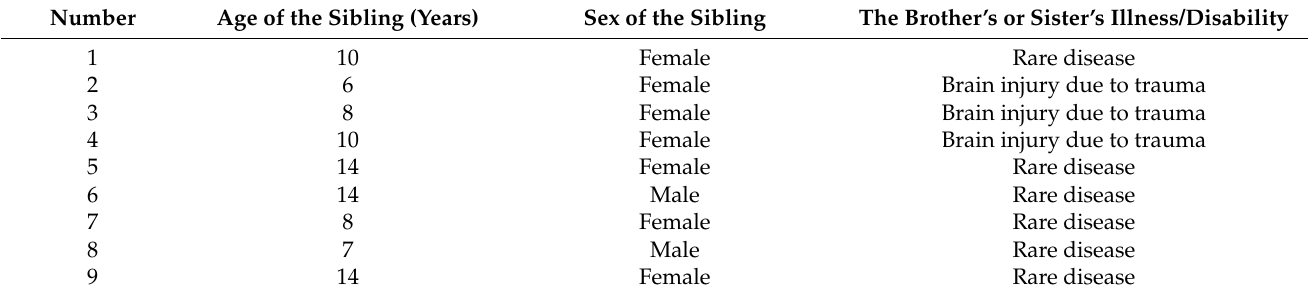
Table 1. Siblings included in the